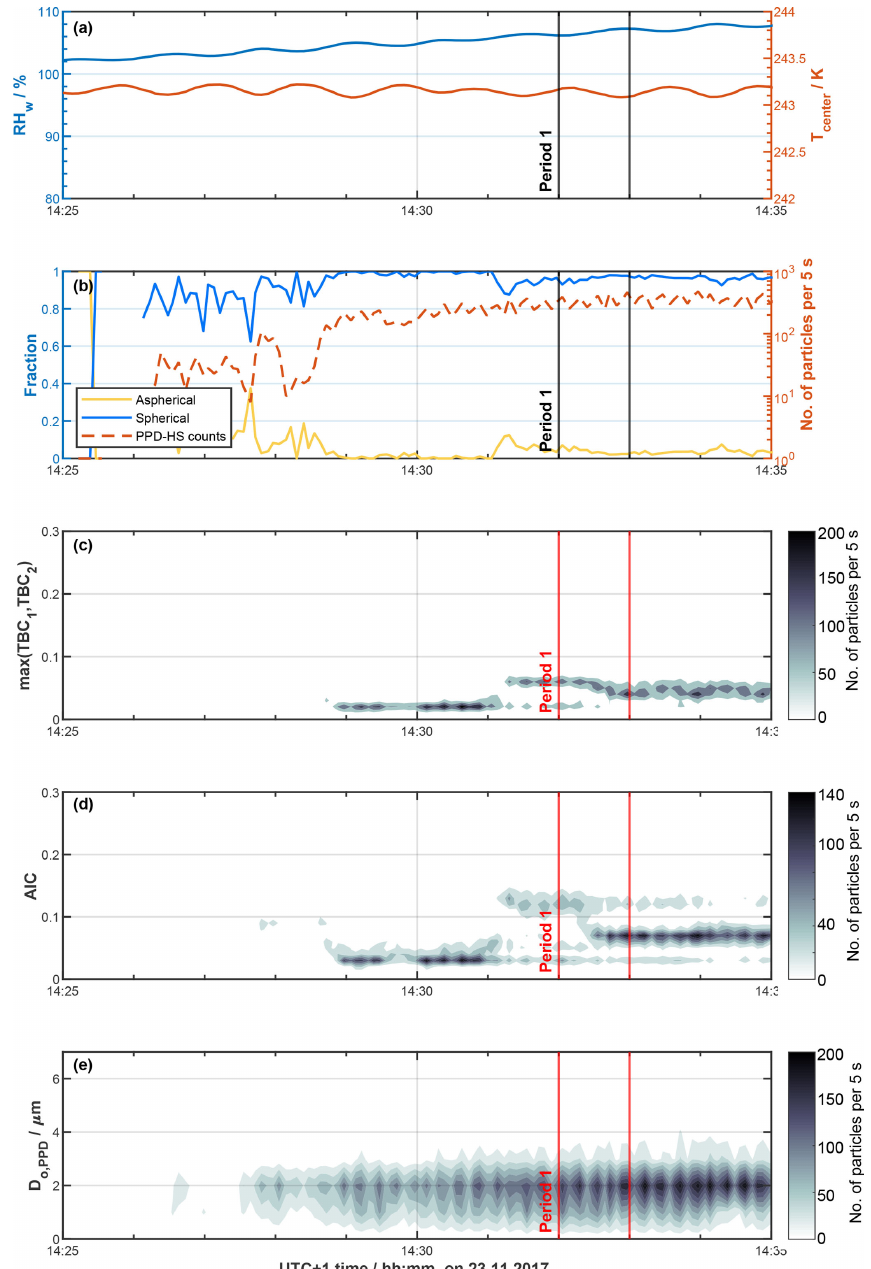
Figure 10. Freezing experiments of NH 4 NO 3 aerosol using HINC at T = 243K and a residence time τ = 22s. Panels and symbols as